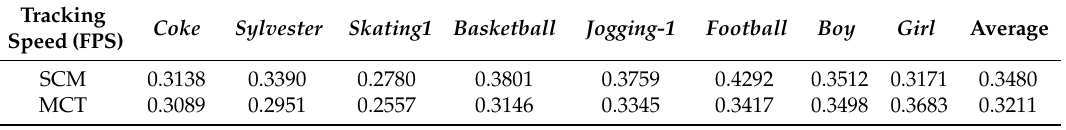
Table 6. Tracking speed comparison of the algorithms.